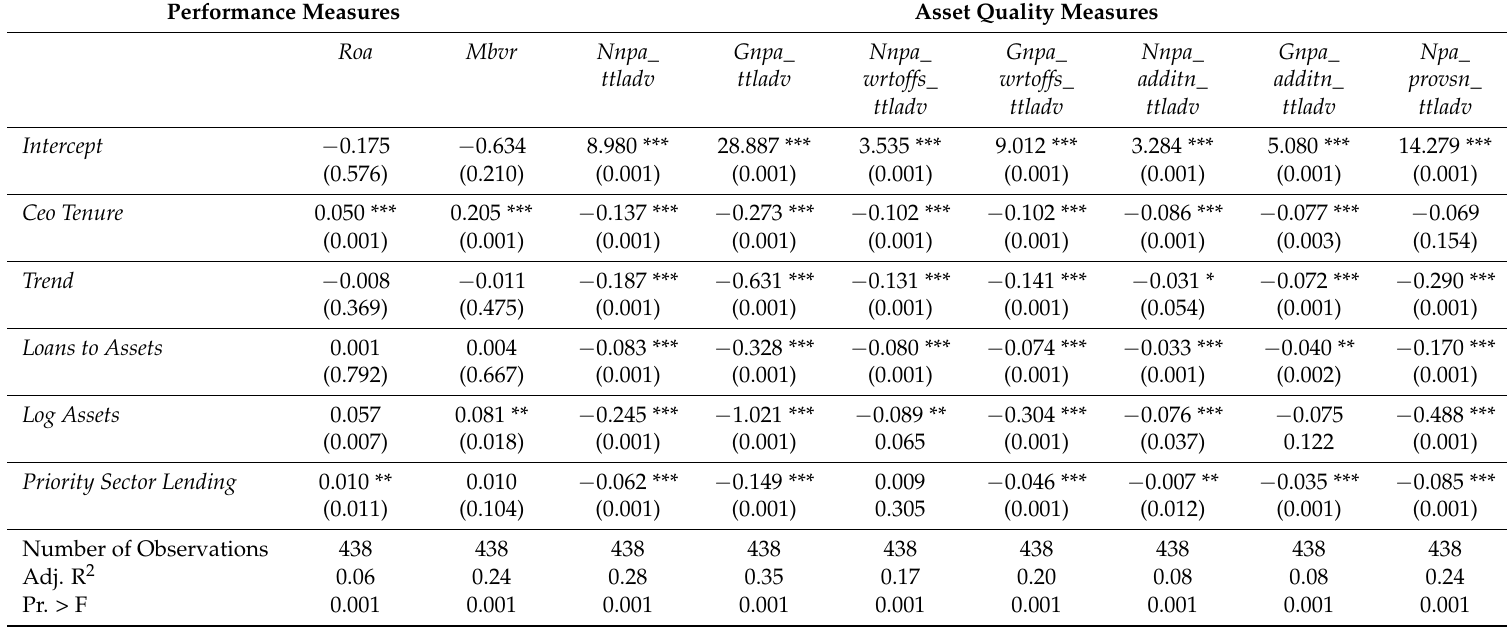
Table 8. CEO Tenure and Bank